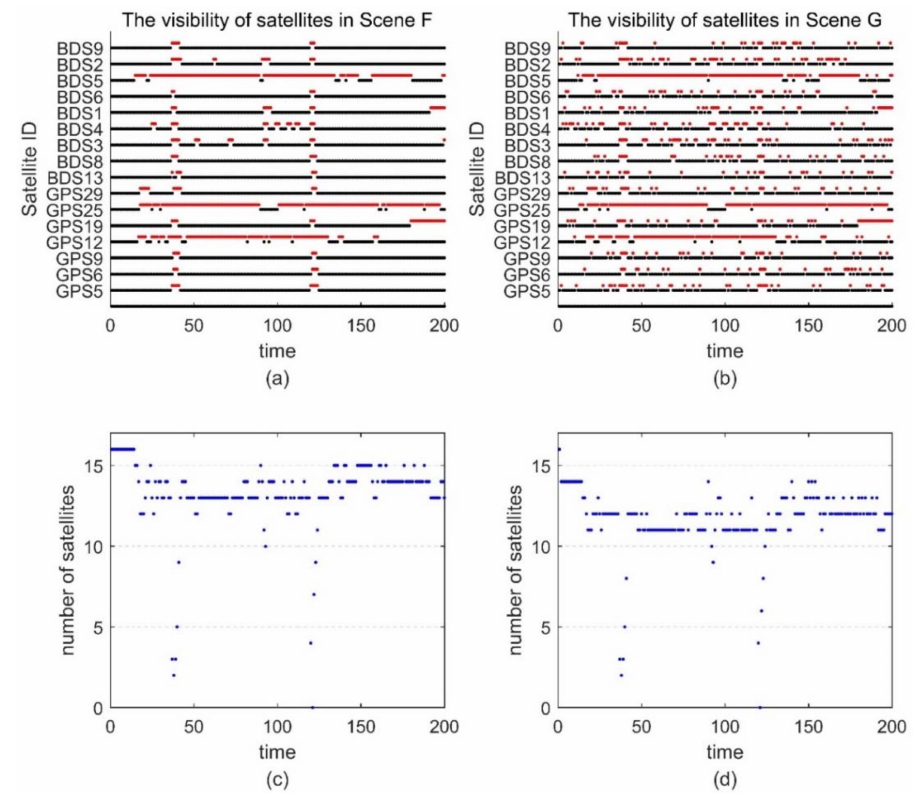
Figure 15. ( a ) The satellite visibility of the 200-s real data for Scene F; ( b ) The satellite visibility for Scene G; ( c ) The number of satellites in Scene F; ( d ) The number of satellites in Scene